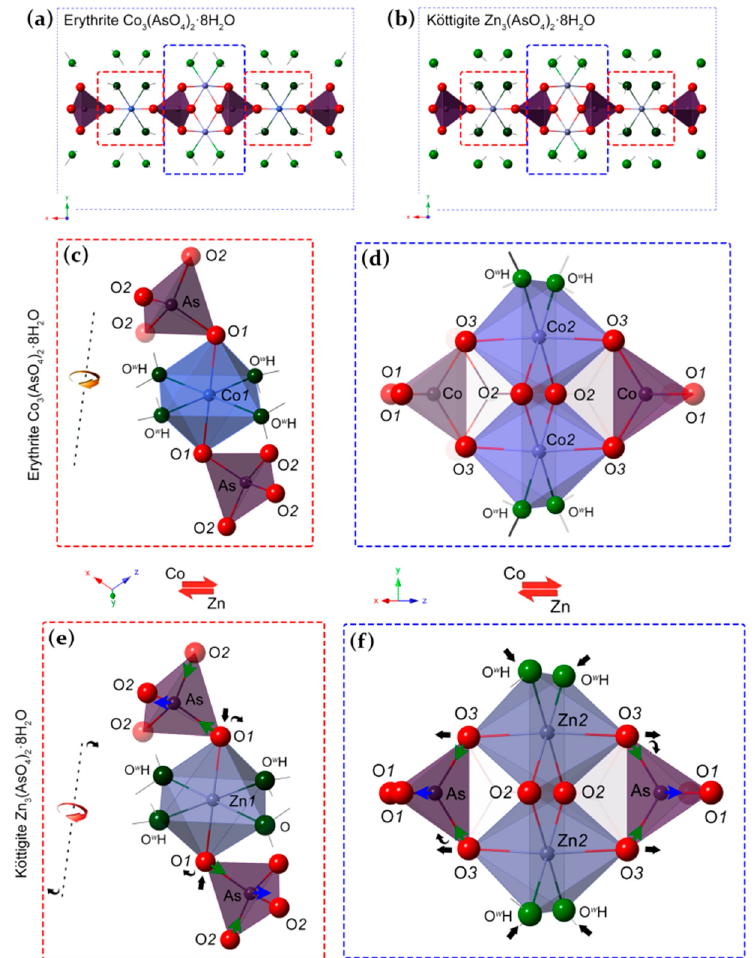
Figure 13. Structure of erythrite ( a ) and köttigite ( b ). Close-ups ( c – f ) show insular M1 and double edge-sharing M2 octahedra with adjacent AsO 4 tetrahedra. Black, blue, and green arrows show rotation, shortening, or lengthening of bonds. The dotted line represents the O1– M1 –O1 axis.